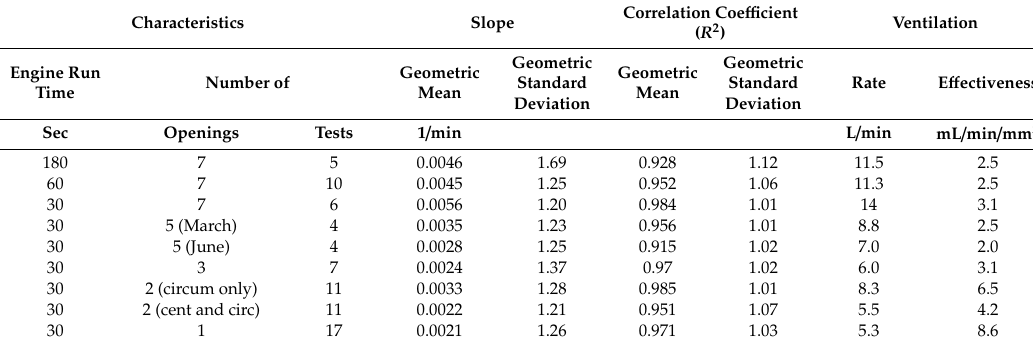
Table 3. Summary of parameters for lines fitted to data points, (C / C 0 ) versus time (min), using the second-order polynomial